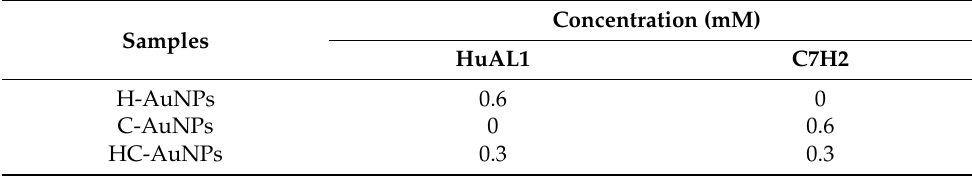
Table 2. Concentration of peptides per-well for each